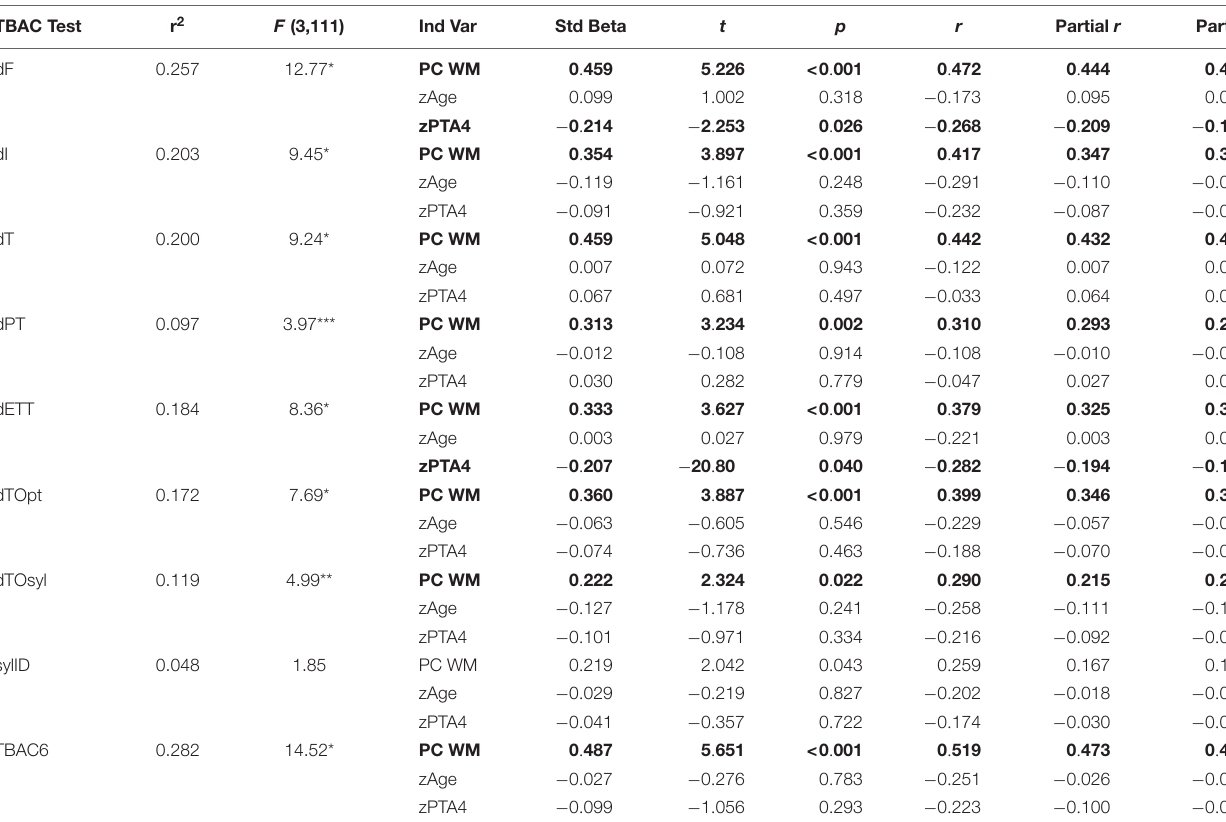
TABLE 3 | Results of the linear-regression analyses for each TBAC score (in RAU) for 115 older adults only. TBAC